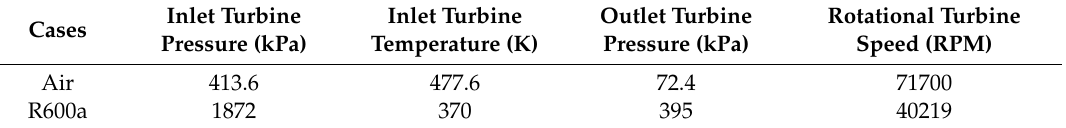
Table 1. Boundary conditions of two cases for the turboexpander.